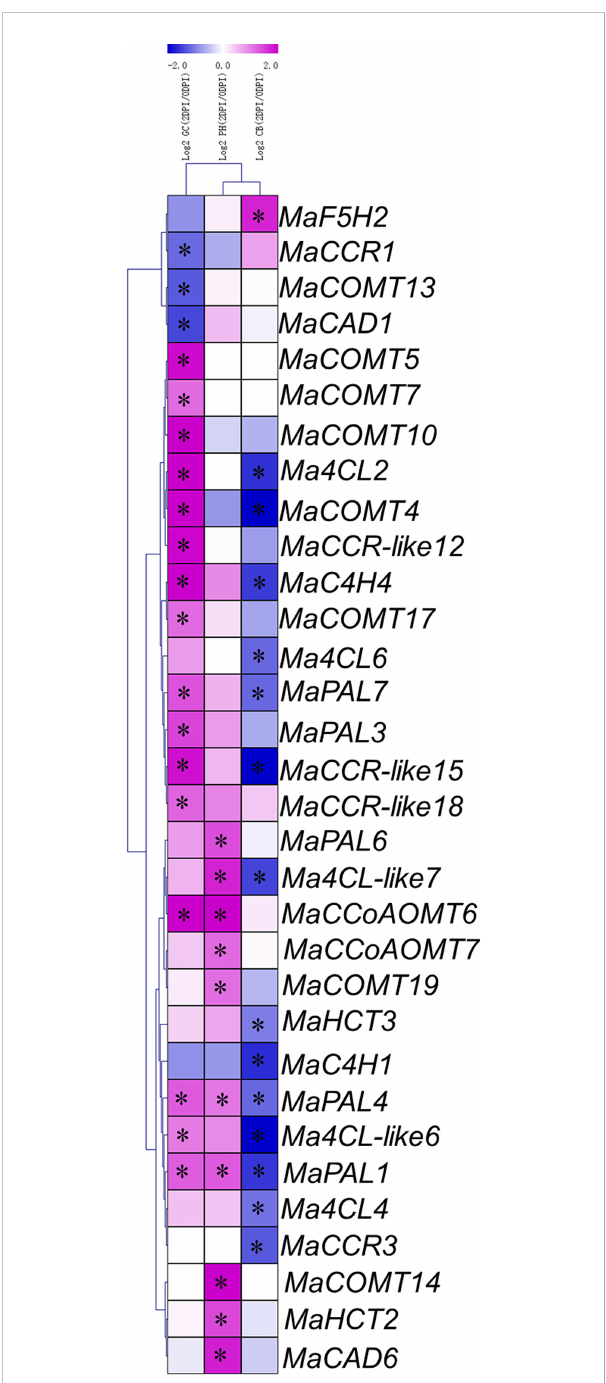
FIGURE 6 Expression patterns of lignin biosynthesis genes in Cavendish banana (CB), GCTCV-119 (GC) and Pahang (PH) inoculated with Foc TR4. The Log2-based fold change was used to create the heatmap. Differences in gene expression changes were shown in color as the scale. * Signi fi cant difference at P <